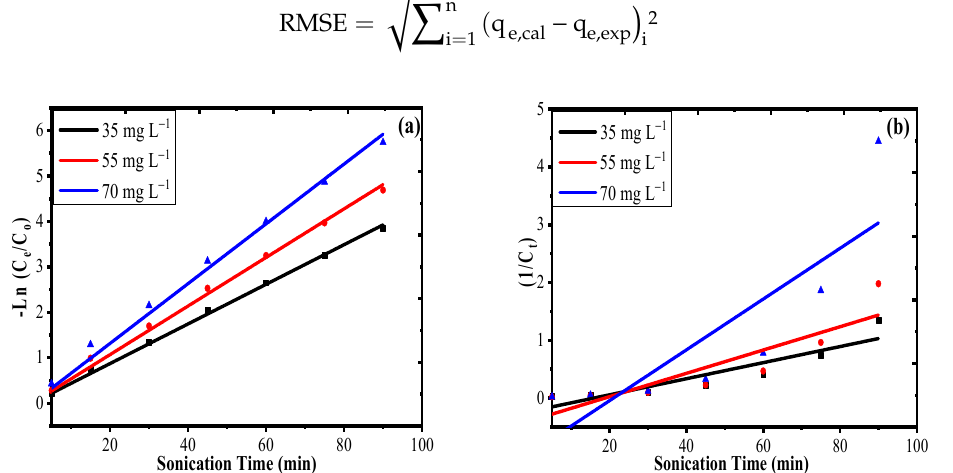
Table 2. Pseudo first- and second-order kinetic parameters for photodegradation of malachite green by chitosan-ascorbic acid@NiFe 2 O 4 for 35, 55, and 70 mg·L –1 MG degradation at pH 8 for a time irradiation range of 5–90 min at 25 °C.